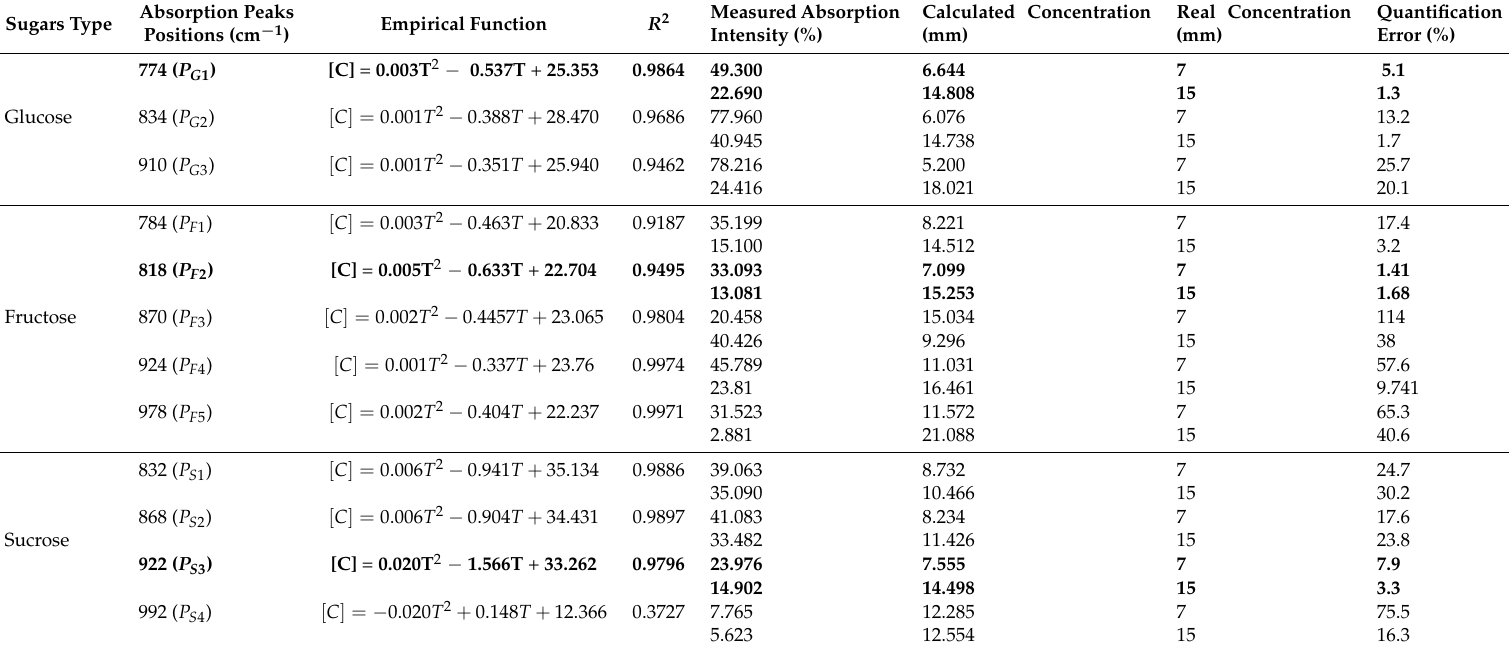
Table 2. Absorption peaks characteristics and quantification results of unknown solution concentration based on quadratic